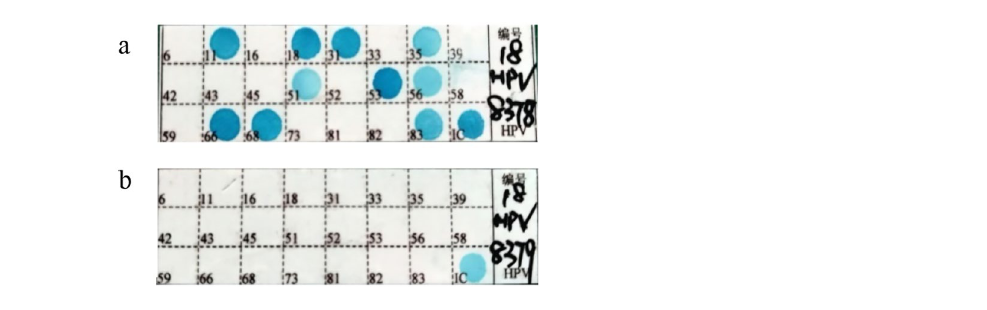
Figure 5. ( a ) HPV positive coinfection with 10 subtypes; ( b ) HPV negative